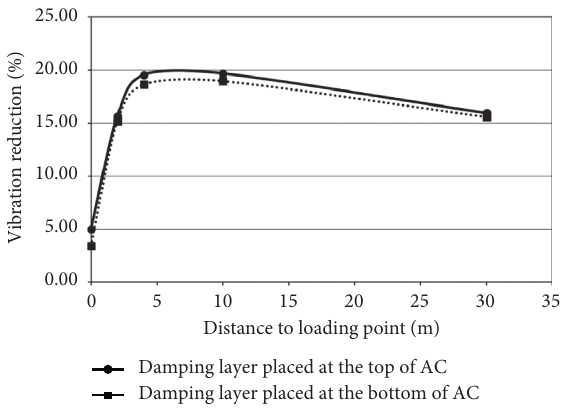
Figure 3: The relationship between the monitored points and vibration